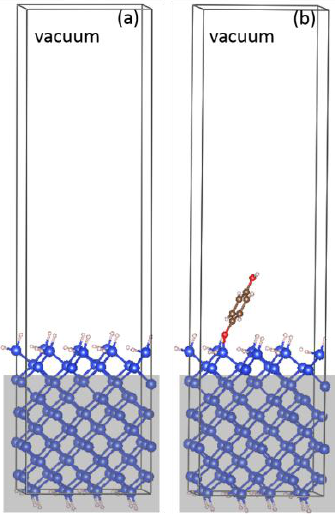
Figure 1. A dihydride-passivated ( a ) and BQ-adsorbed ( b ) Si slab with bulk atoms fixed (atoms in shadow) modeled using periodical boundary condition in VASP. The vacuum region was approximately 25 Å .